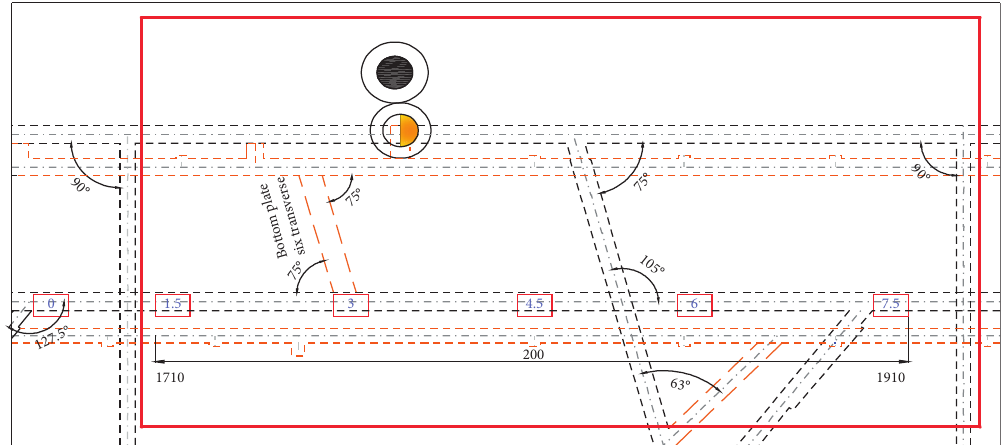
Figure 9: The layout of convergence survey points in the bottom drainage